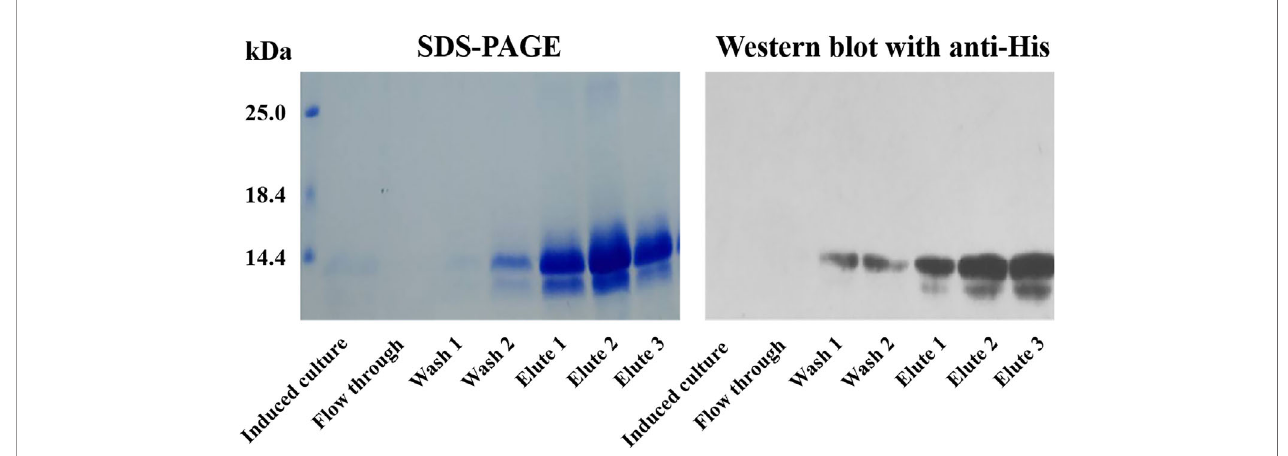
FIGURE 1 | IMAC puri fi cation of recombinant Sj- Cys expressed in P. pastoris GS115. The r Sj -Cys with His-tag at C-terminus was expressed as a soluble protein in the culture medium. After binding on the nickel column, r Sj -Cys was eluted in a buffer containing imidazole. The puri fi ed protein was recognized by the anti-His